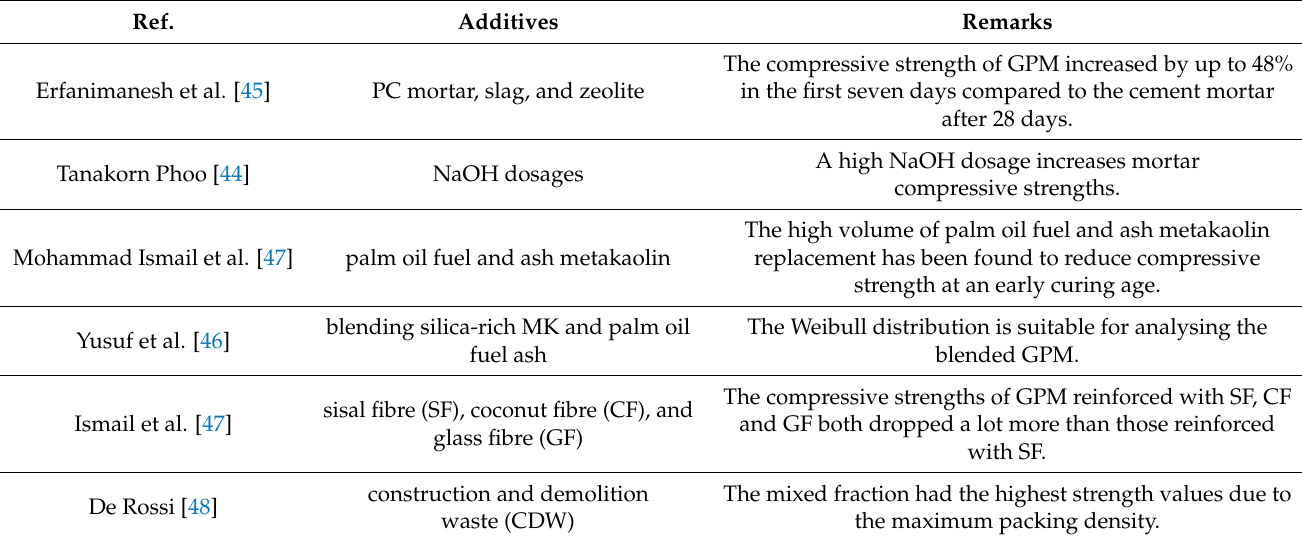
Table 2. Effect of different additives on geopolymer concrete compressive